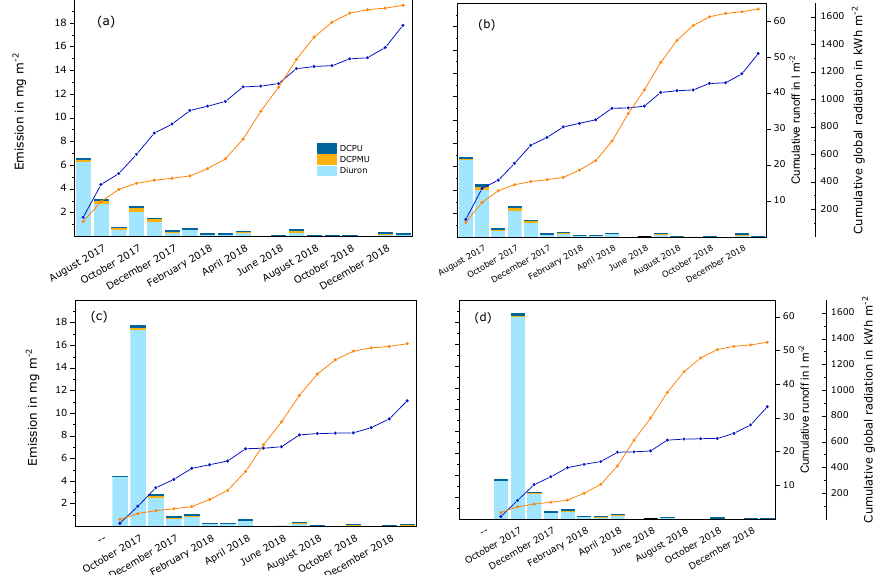
Figure 3. Monthly emissions of diuron and transformation products from a white and a red paint film during semi-field experiments that were started in July 2017 (experiment A) and September 2017 (experiment B). The columns represent the substances that were detected in runoff samples per month. The blue curves show the cumulated volume of runoff samples per surface area for each experiment. The orange curves show the cumulative global radiation during the experiment. ( a ) Experiment A, white paint; ( b ) experiment A, red paint; ( c ) experiment B, white paint; ( d ) experiment B, red paint.